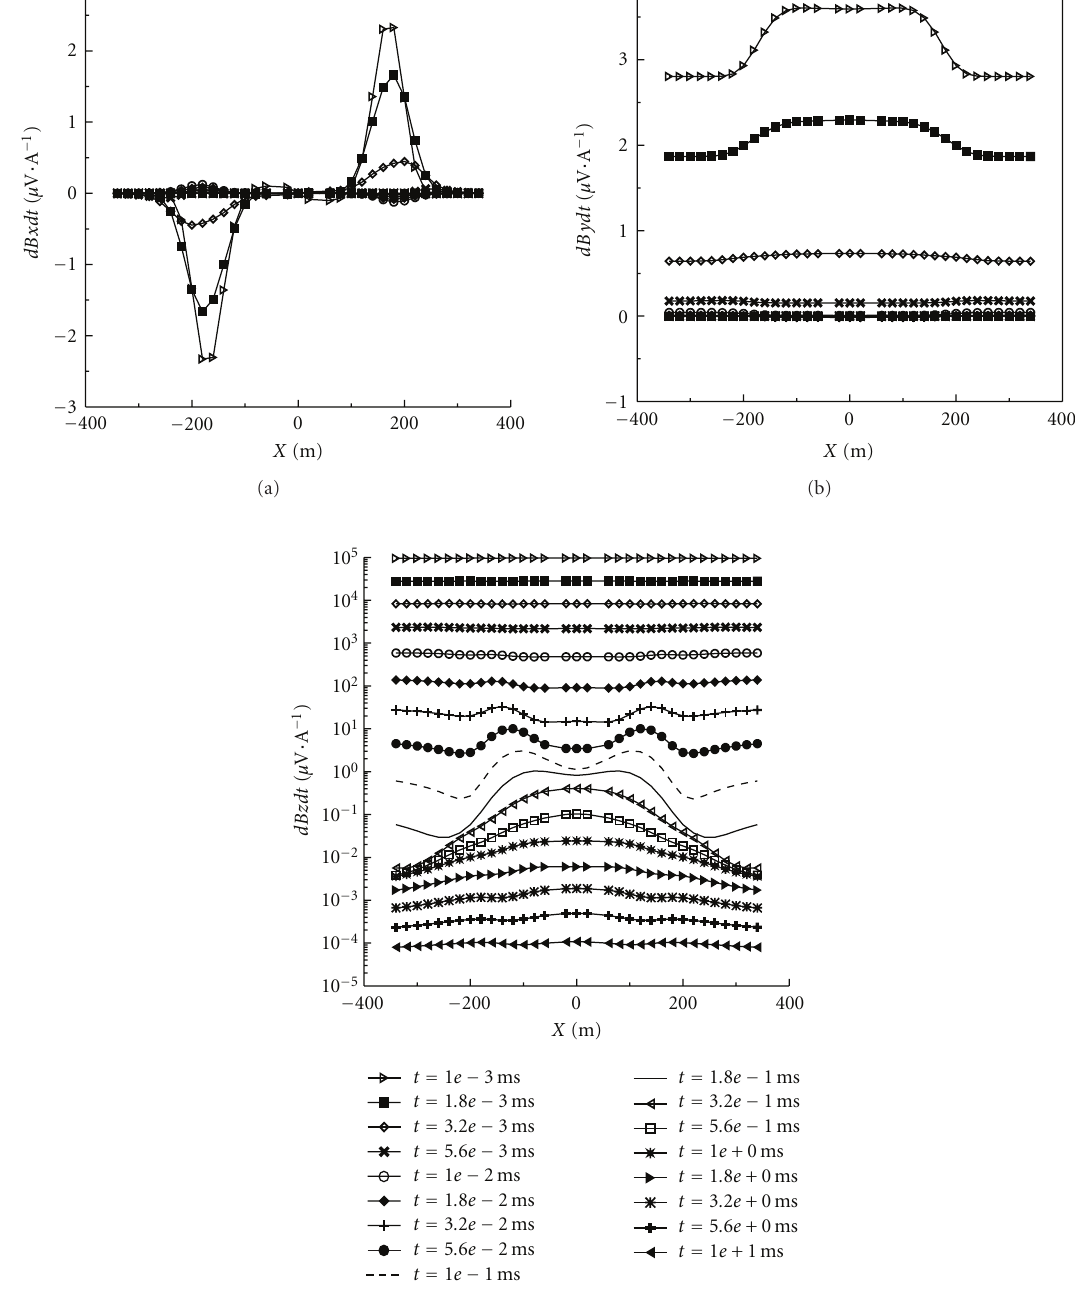
Figure 4: TEM profiles of horizontal tabular orebody for (a) the horizontal EMF in x direction, (b) the horizontal EMF in y direction, and (c) the vertical